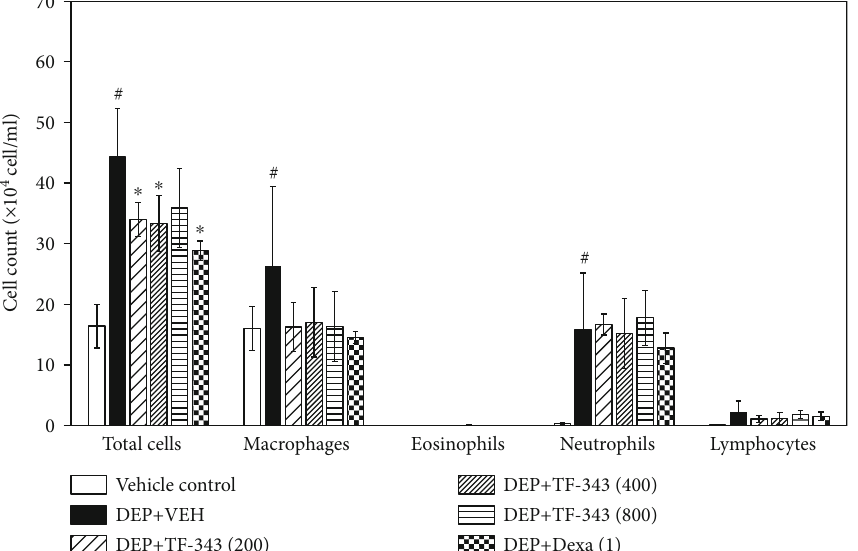
Figure 3: Changes in the cell population of BALF from mice treated with vehicle (VEH) or DEP, alone or in conjunction with TF-343 (200, 400, or 800 mg/kg) or Dexa (1 mg/kg). Data represent mean ± SD ( n = 5 per group). # P < 0 : 05 vs. vehicle control, ∗ P < 0 : 05 vs. DEP+VEH.